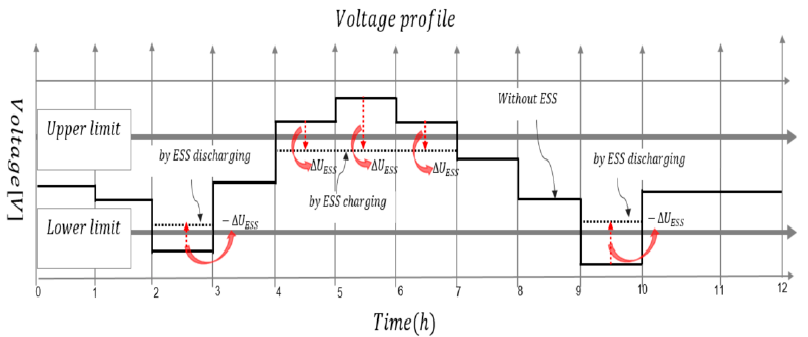
Figure 5. Operation concept of the proposed method.